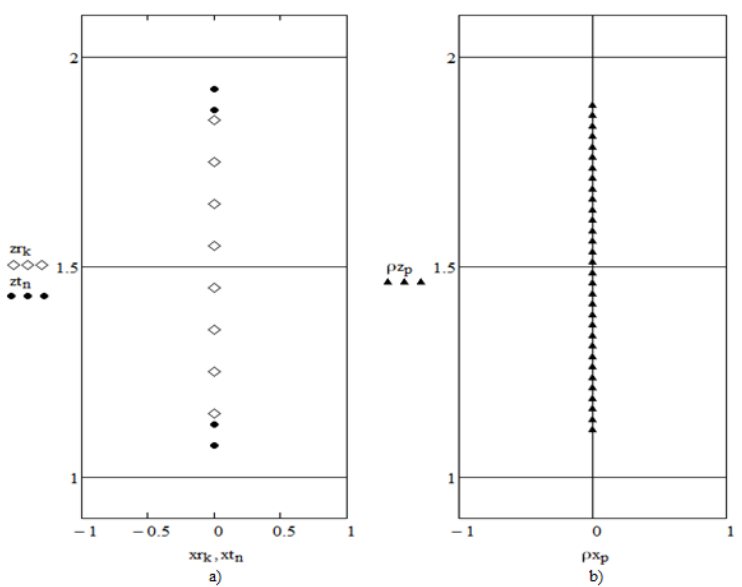
Fig. 1. An example of the phase center locations in linear subarrays in MIMO antenna systems (a) and a virtual antenna array consisting of transceiver phase centers (b). The center of MIMO antennas system is located at the height of 1.5 m; rhombuses – receiving phase centers; black ones – transmitting phase centers; triangles – virtual transceiver phase centers. The axis coordinates on the figure are in meters.